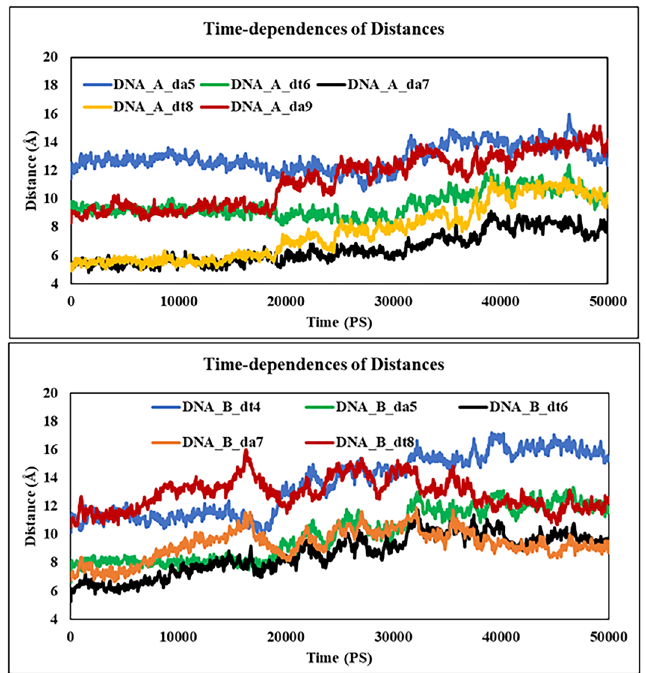
Figure 13. Time-dependence of distances for the center of masses of DNA bases with PLB showing the important interacting bases of strand A (Top) and strand B